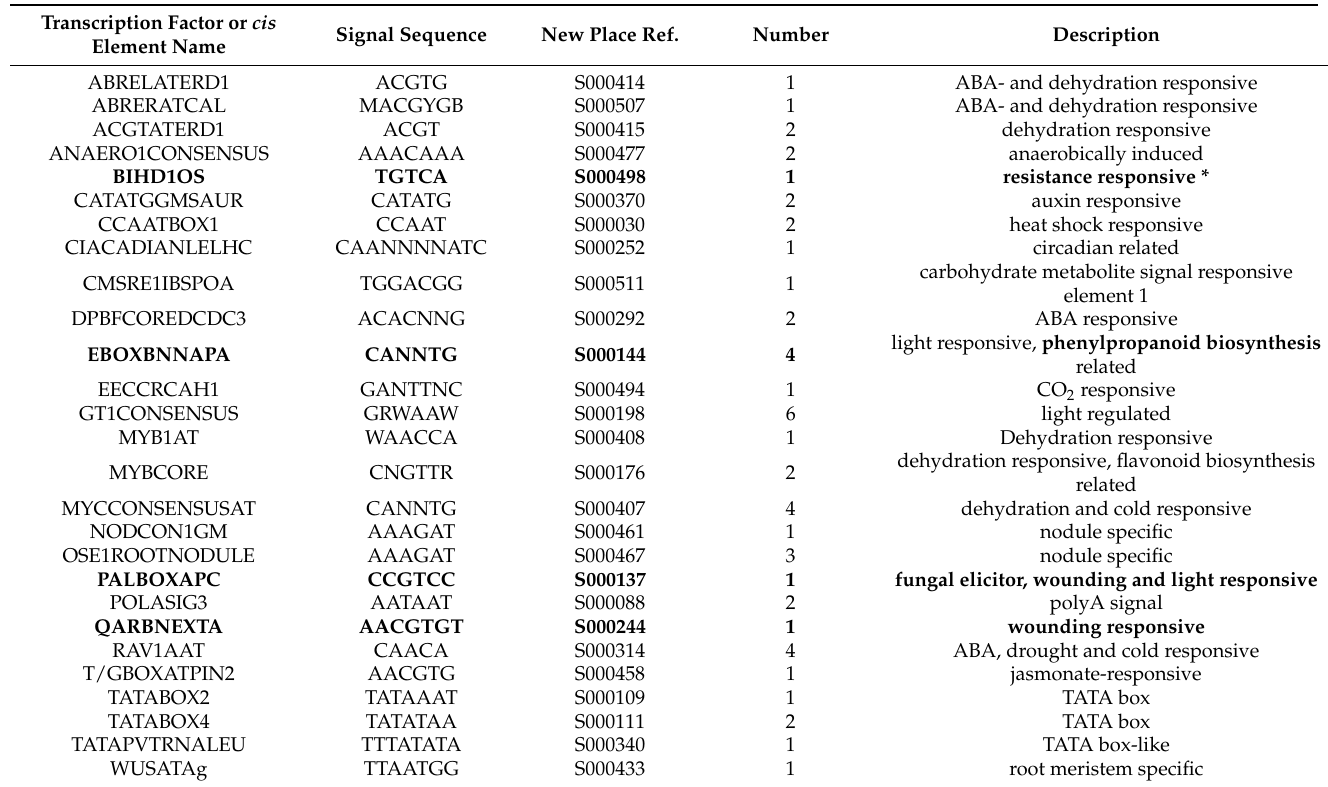
Table 1. Predicted cis elements specific for the 507 bp-long promoter of AtMYB59